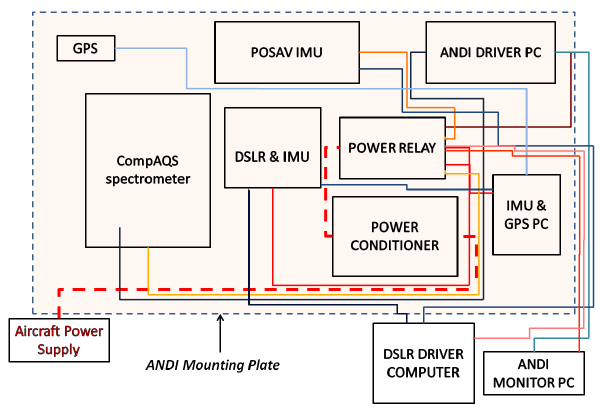
Figure 1. ANDI instrument schematic showing main components: the red lines represent power connections, and the blue lines repre- sent communication